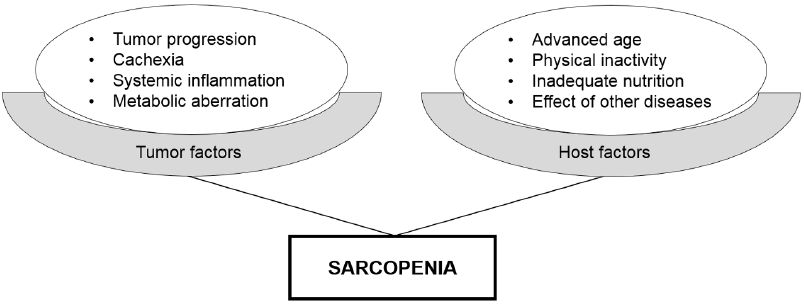
Figure 2. Hybrid nature of sarcopenia.